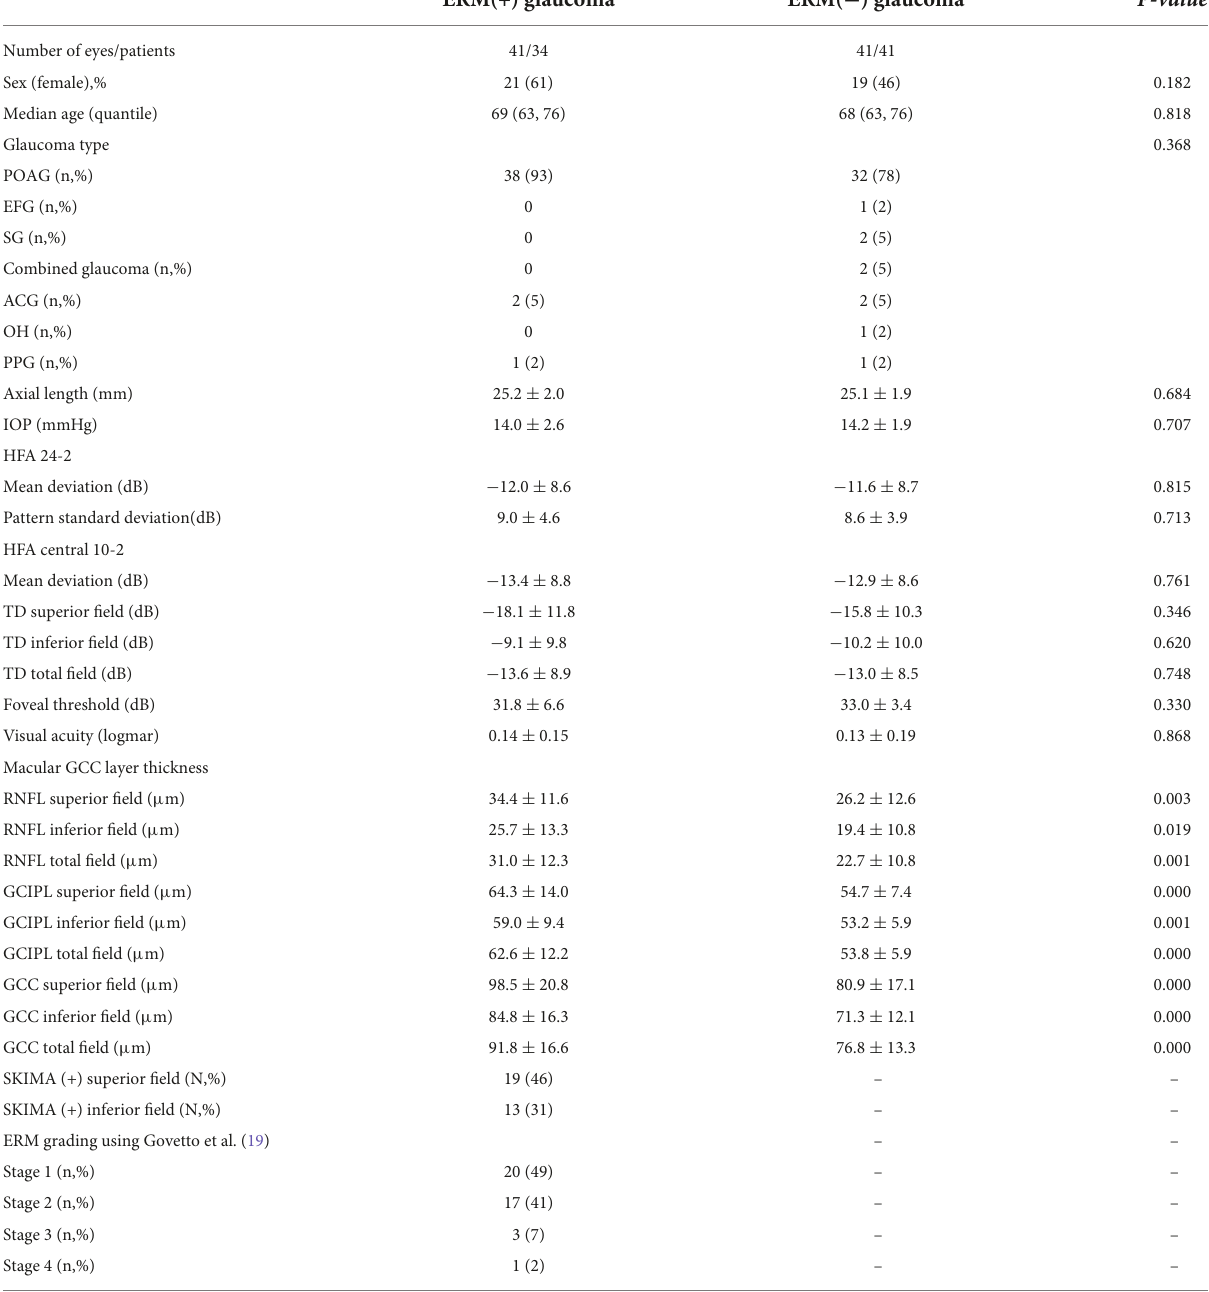
TABLE 1 Patient demographic, HFA, and OCT